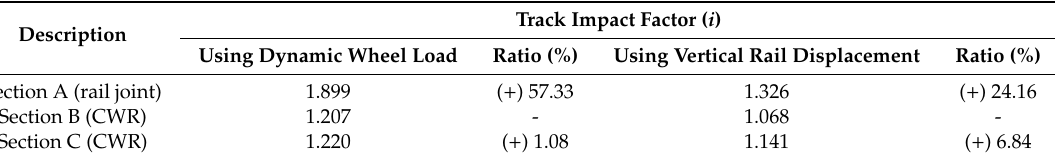
Table 4. Comparisons of TIF evaluation methods.